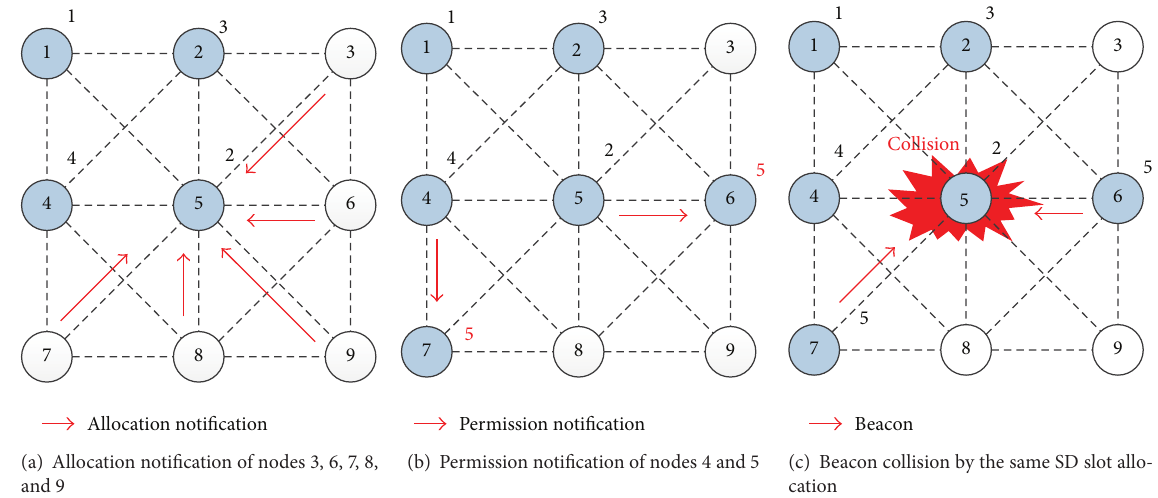
Figure 9: Main reason for performance degradation: distributed permission